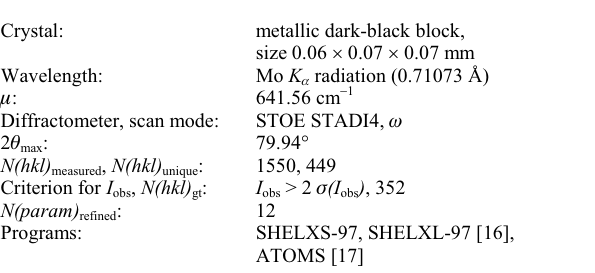
Table 2. Atomic coordinates and displacement parameters (in Å 2 ) .